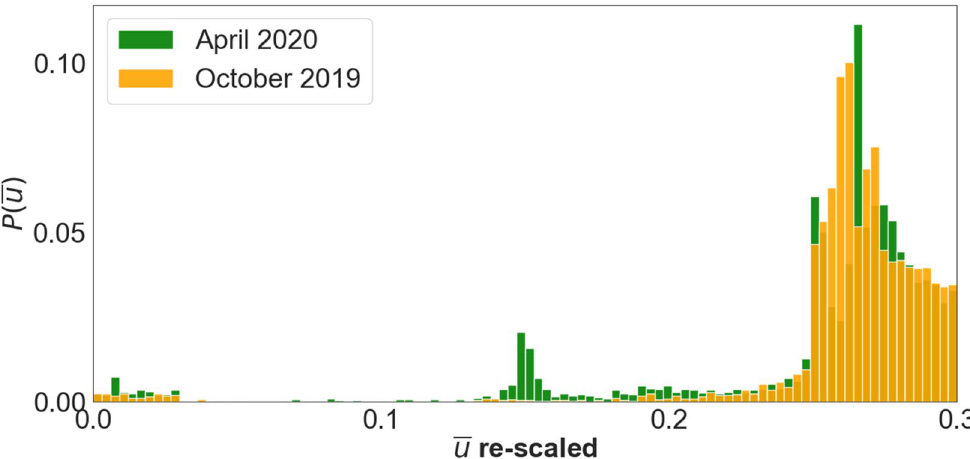
− u = 1 − u constructed from the distributions of Fig. 5 and Figure 6. Probability densities of the variable rescaled to the values between 0 and 0.3 to account for a heavily restricted